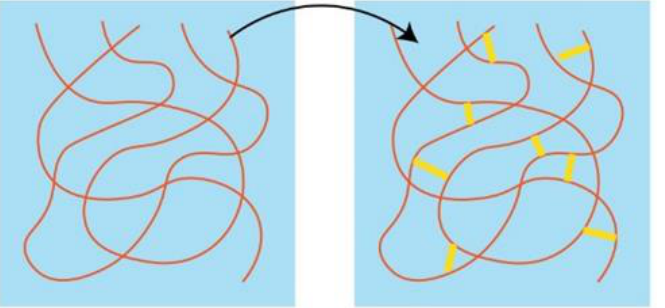
Figure 4. Schematic of the interaction between engineering molecules of heat transfer between chains. Adapted with permission [29], Copyright 2021, Nature Materials.